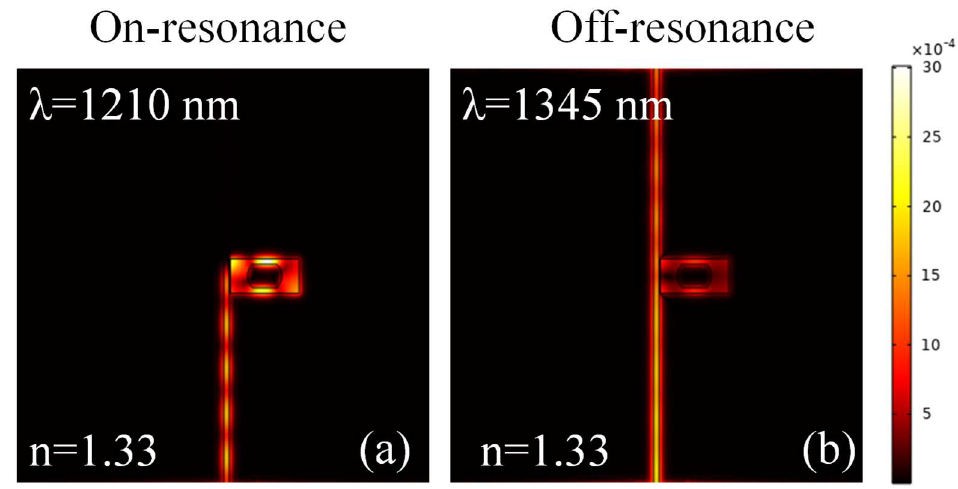
Figure 3. H-field distribution at ( a ) an on-resonance state and ( b ) an off-resonance